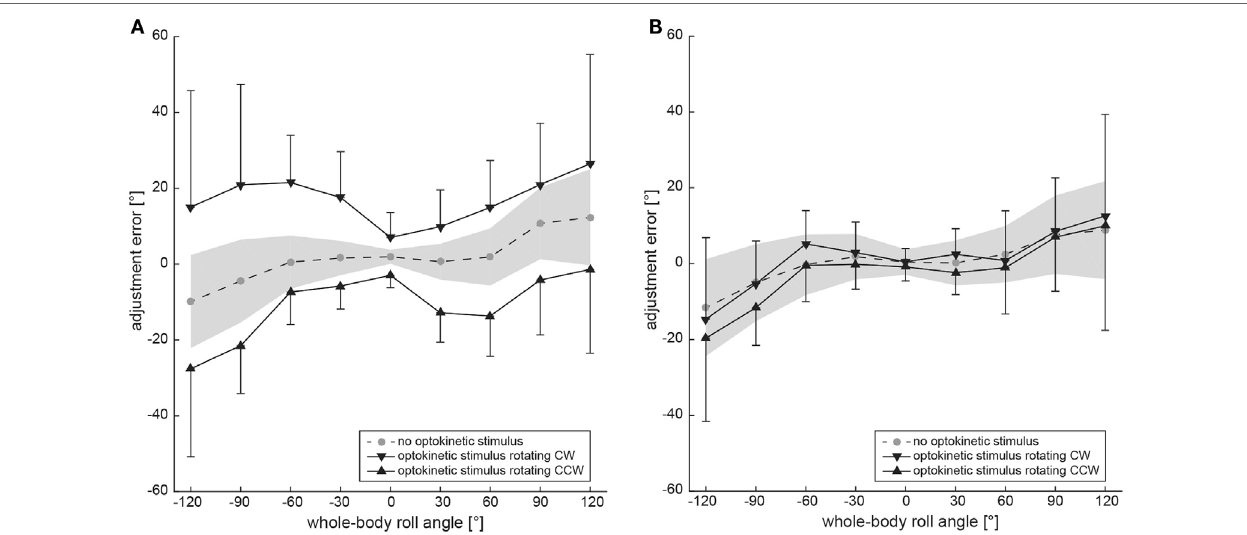
FigUre 3 | Overall mean adjustment errors for the SVV paradigm (a) and the subjective haptic vertical (SHV) paradigm (B) are plotted against whole-body roll orientation. Results from the three different trial conditions are shown separately. The gray circles interconnected with a dashed line refer to the baseline SVV measurements (no optokinetic stimulus). The inverted black triangles represent trials with the optokinetic stimulus rotating CW and the black trials refer to trials with the optokinetic stimulus rotating CCW. Whereas black bars reflect ± 1 SD for the test trials, a gray shaded-area represents ± 1 SD of the baseline trials.